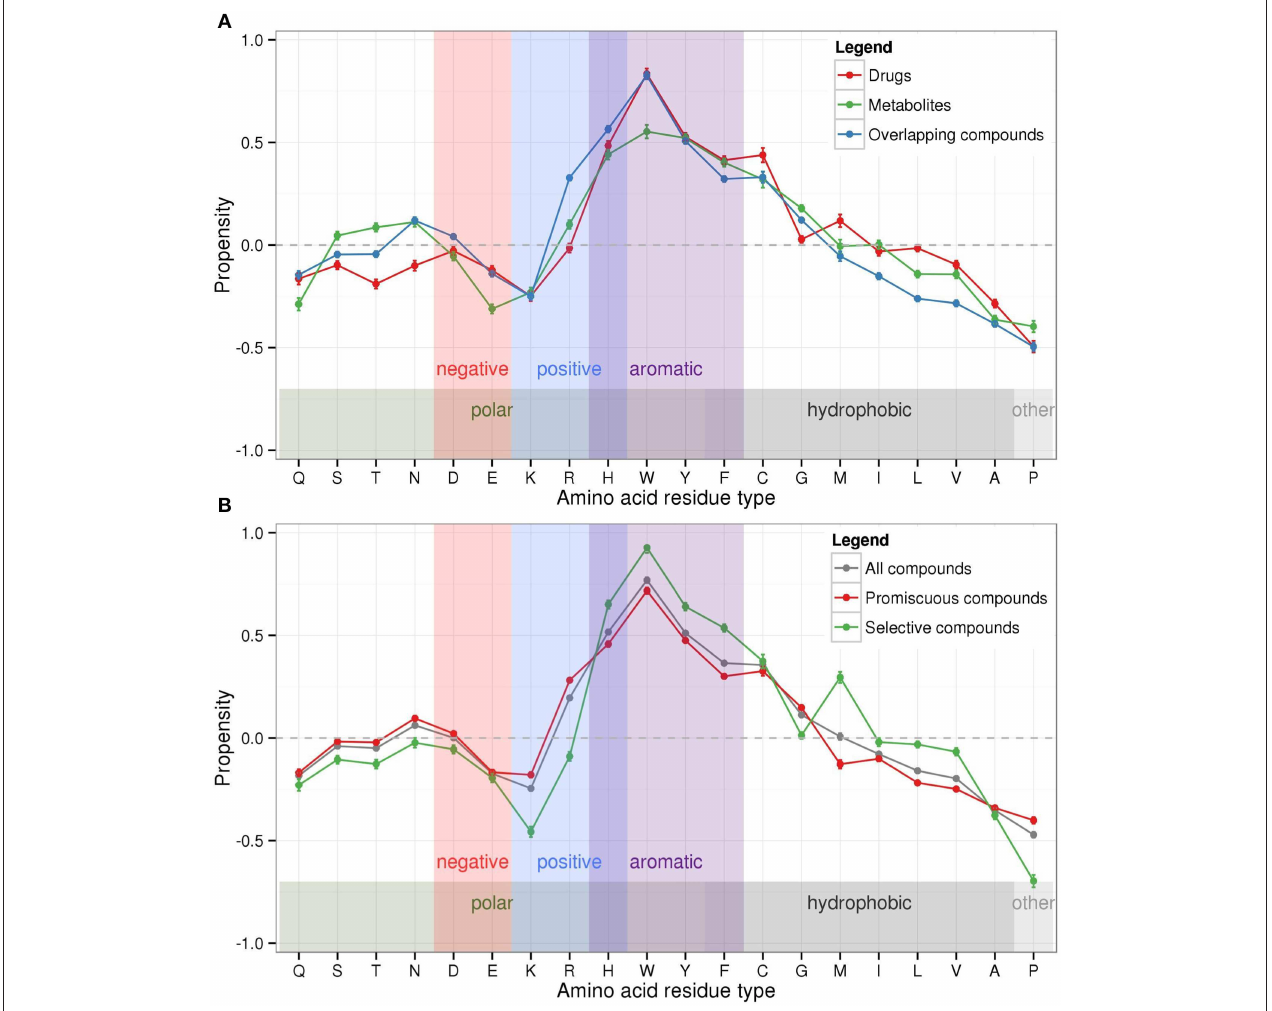
FIGURE 4 | Logarithmic propensities of amino acid binding pocket composition. Propensities were calculated for the amino acid composition of binding pockets in relation to other protein regions with respect to (A) the three bound compound classes drugs (red), metabolites (green), and overlapping compounds (blue), and (B) binding pockets associated with all bound compounds (gray), promiscuous compounds (red), and selective compounds (green), respectively. The background shading refers to the physicochemical properties of amino acids according to Taylor (1986). Error bars denote the estimated standard error of the mean values. (Connecting lines between propensity values serve improved traceability